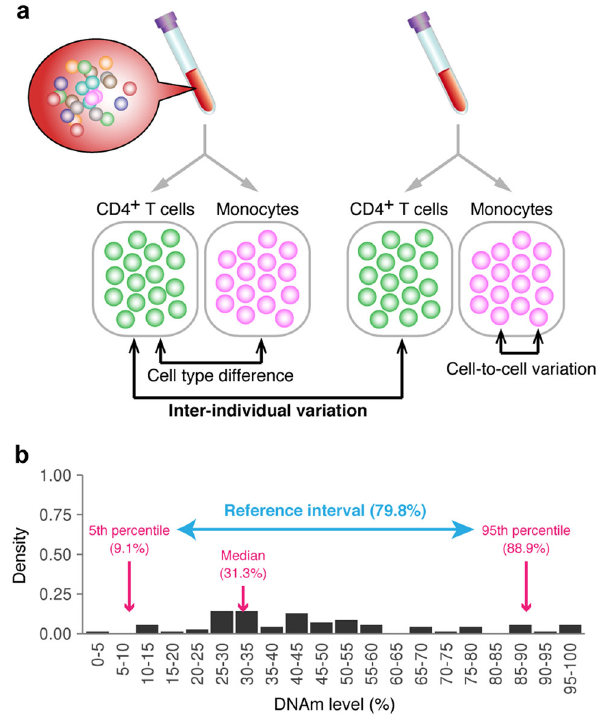
Fig. 1 DNAm variations in puri fi ed blood cells. a Schematic representation of sources of DNAm variation in blood cells. b De fi nition of reference interval as an indicator of inter-individual DNAm variability. The reference interval for a CpG site was de fi ned as the difference between the 95th and 5th percentiles of DNAm levels across